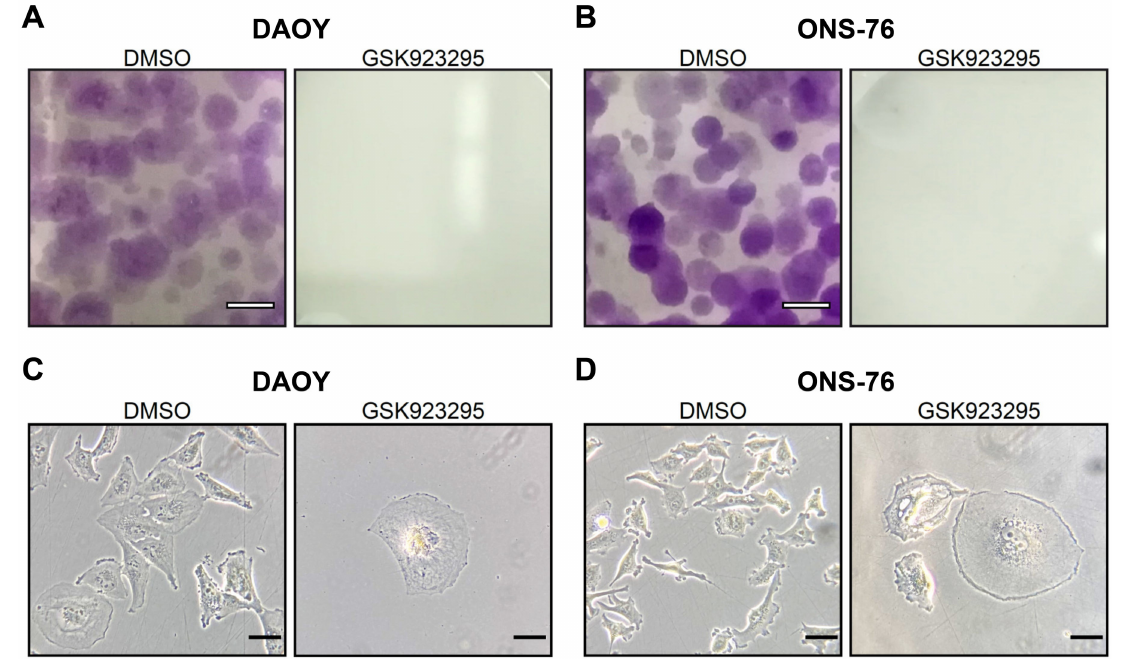
Figure 5. CENPE inhibition abolished the in vitro clonogenic potential of SHH MB cells. ( A , B ) Low magnification images of plates of DAOY and ONS-76 cells, treated with DMSO or GSK923295 25 nM for 7 days, stained with crystal violet. Scale bars 25 mm ( C , D ) Example of DAOY and ONS-76 treated with DMSO or GSK923295 25 nM for 7 days in phase contrast. Scale bar 20 µ m.